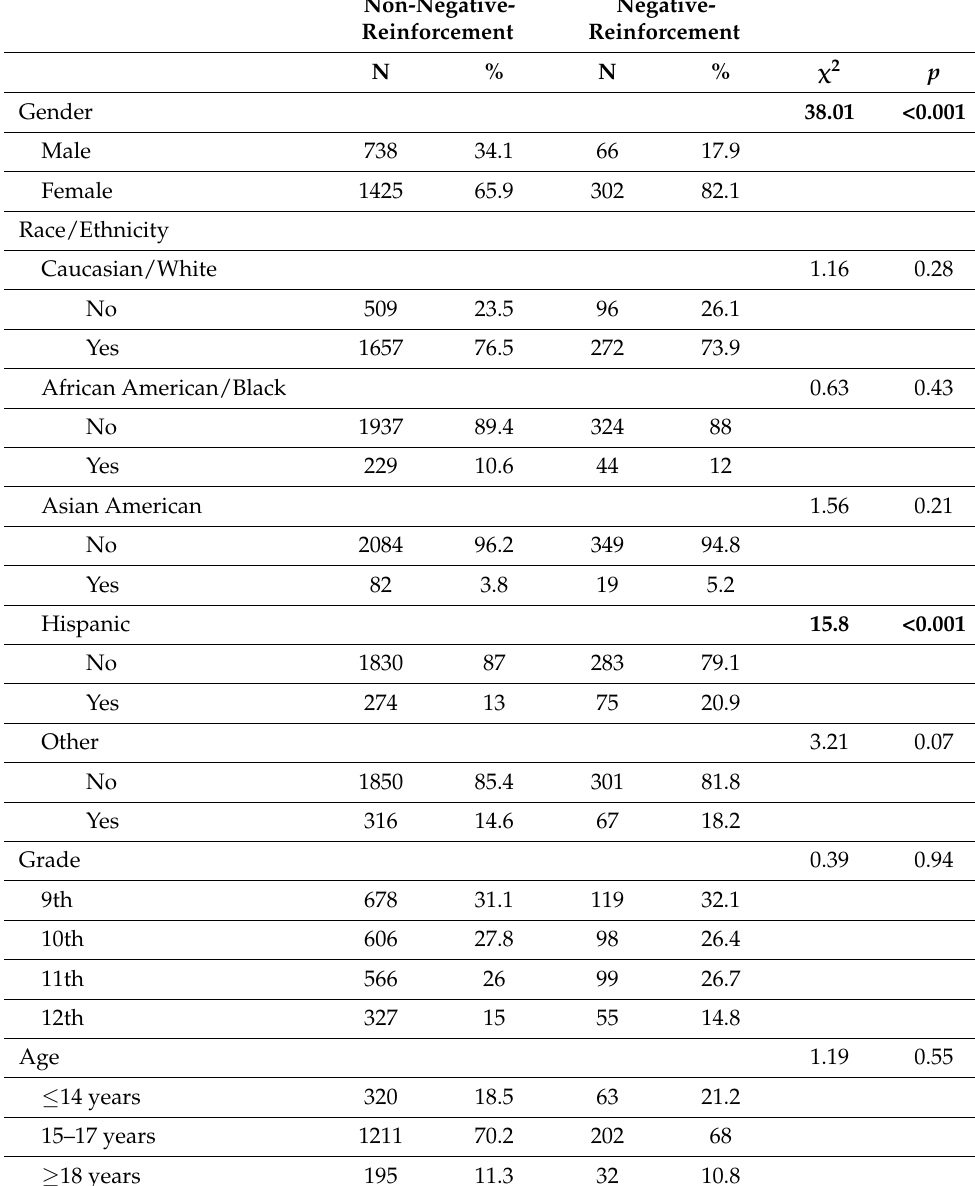
Table 1. Socio-demographic characteristics stratified by negative-reinforcement-shopping status.